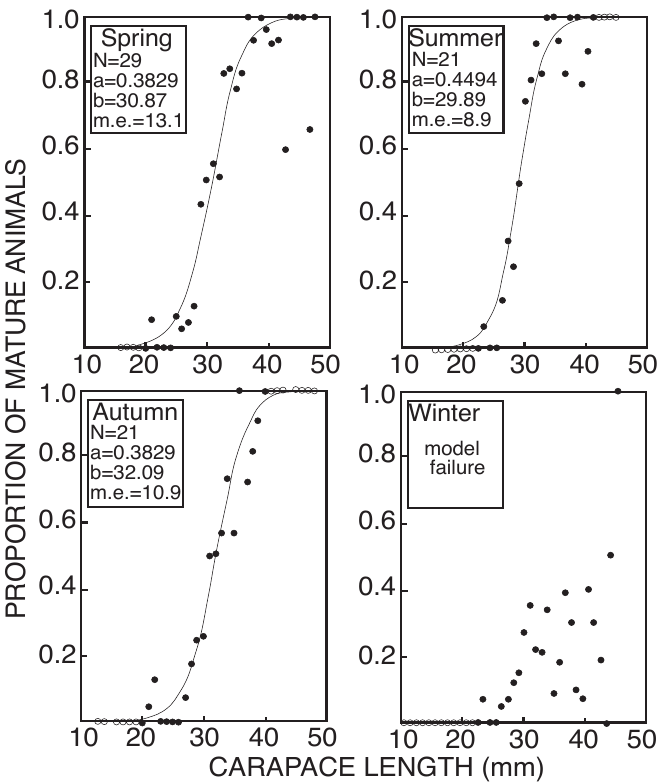
F IG . 2. – Percentage of mature females of Nephrops norvegicus as a function of carapace length, by season, fitted by a logistic curve. Legend: a, “steepness” parameter; b, size at 50% of maturity (SOM); m.e., mean error (loss/ df ). Solid symbols indicate the points included in the estimation, N their number, df the degrees of freedom ( df = N -